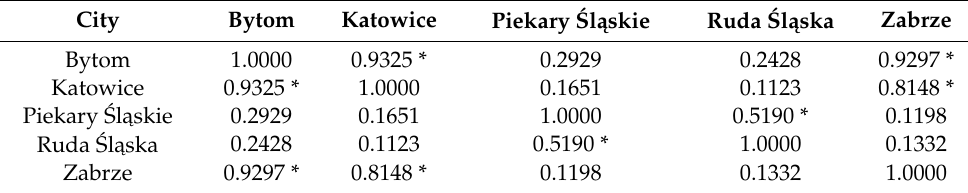
Table 4. Correlation table for deficits/surpluses of the examined cities. City Bytom Katowice Piekary ´Sl ˛askie Ruda ´Sl ˛aska Zabrze Bytom 1.0000 0.4608 0.5243 * 0.5615 * 0.5765 * Katowice 0.4608 1.0000 0.2174 − 0.0862 0.2726 Piekary ´Sl ˛askie 0.5243 * 0.2174 1.0000 0.5207 * 0.4422 Ruda ´Sl ˛aska 0.5615 * − 0.0862 0.5207 * 1.0000 0.5587 * Zabrze 0.5765 *